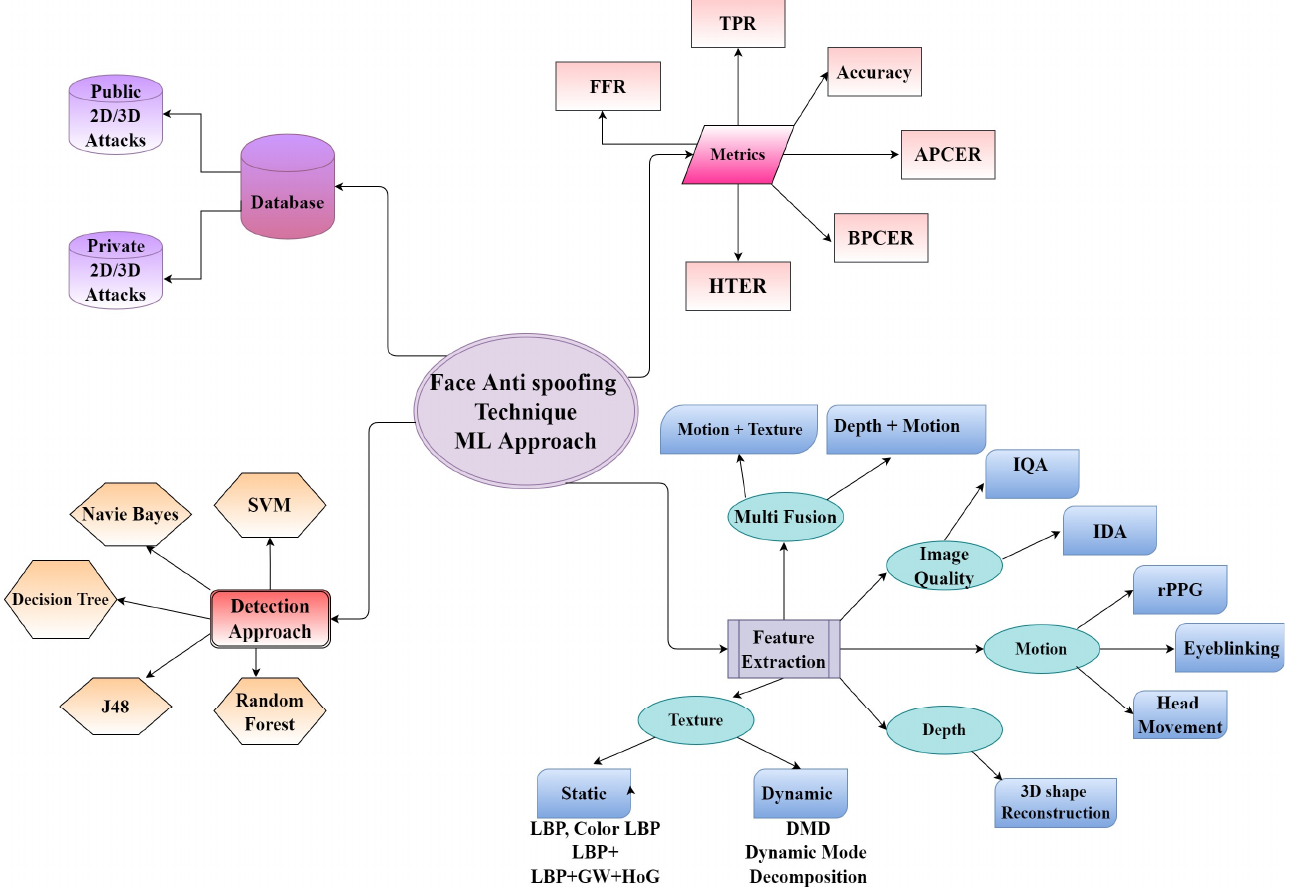
Figure 7. Face anti-spoofing techniques using a machine learning approach.